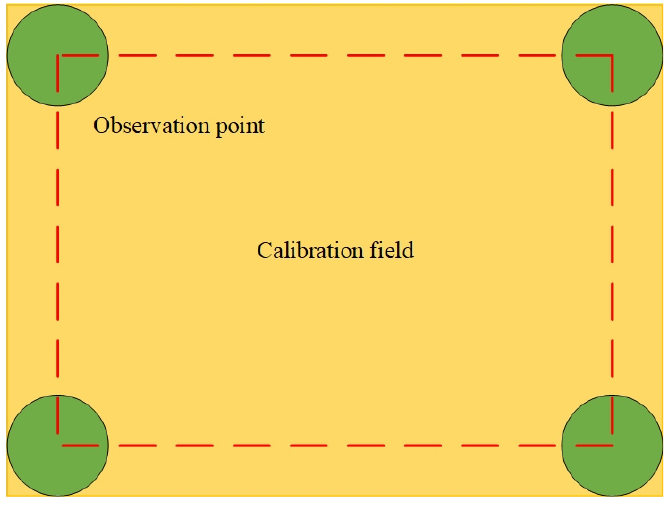
Figure 14. Position relationship between observation point and calibration field.